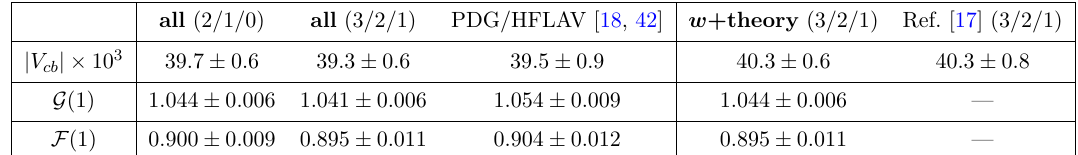
determinations along with the normalization factors Table 3 . Comparison of the V cb j j (1). In our work, these factors are simultaneously produced by the (cid:12)t analysis. G reproduced when we perform the (cid:12)t analysis with the data set of w +theory as shown in table 3. Therefore, we emphasize that the angular distributions are also signi(cid:12)cant for the V cb j j